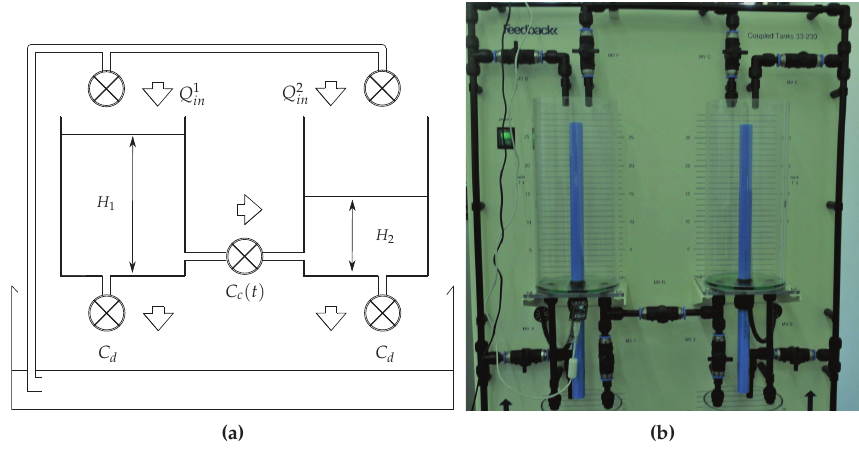
Figure 3. ( a ) Operating system diagram; ( b ) Level control plant used in the